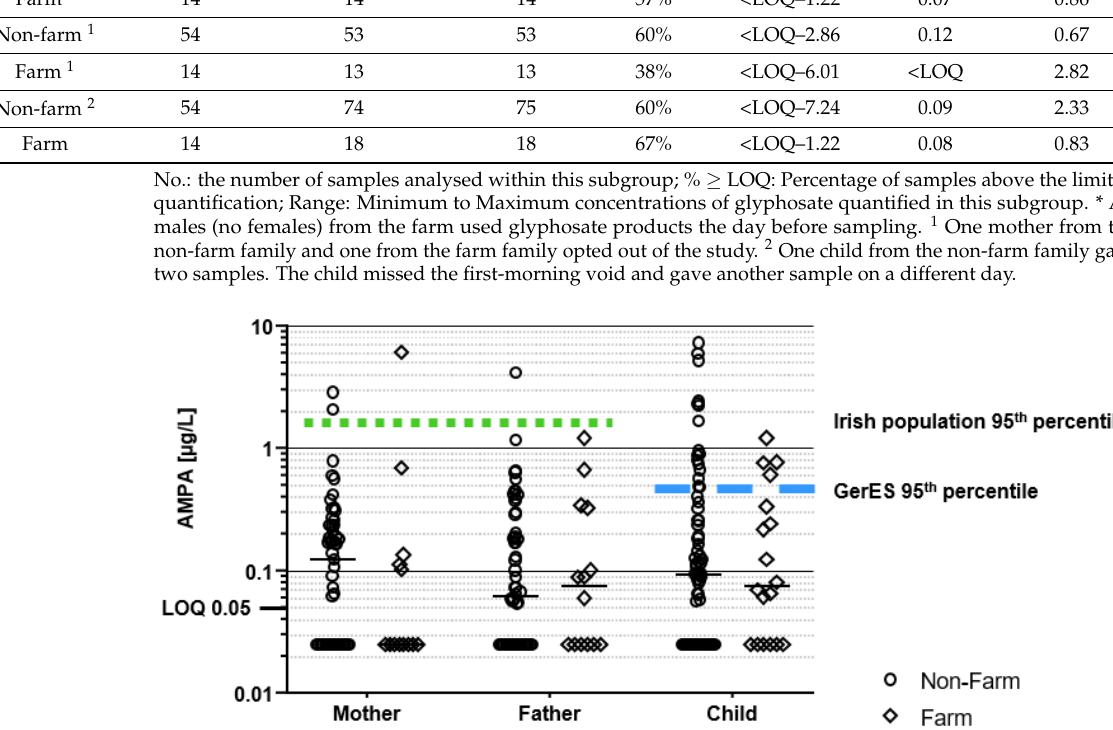
Figure 2. Urinary concentrations of AMPA by the family member (e.g., mother, father, child) and the family type (e.g., farm and non-farm. Comparisons made with the 95th percentile of HBM study of the Irish adult population [57] represented by green dots and the 95th percentile of a German children population from the GerES study [31], represented by a blue dash.